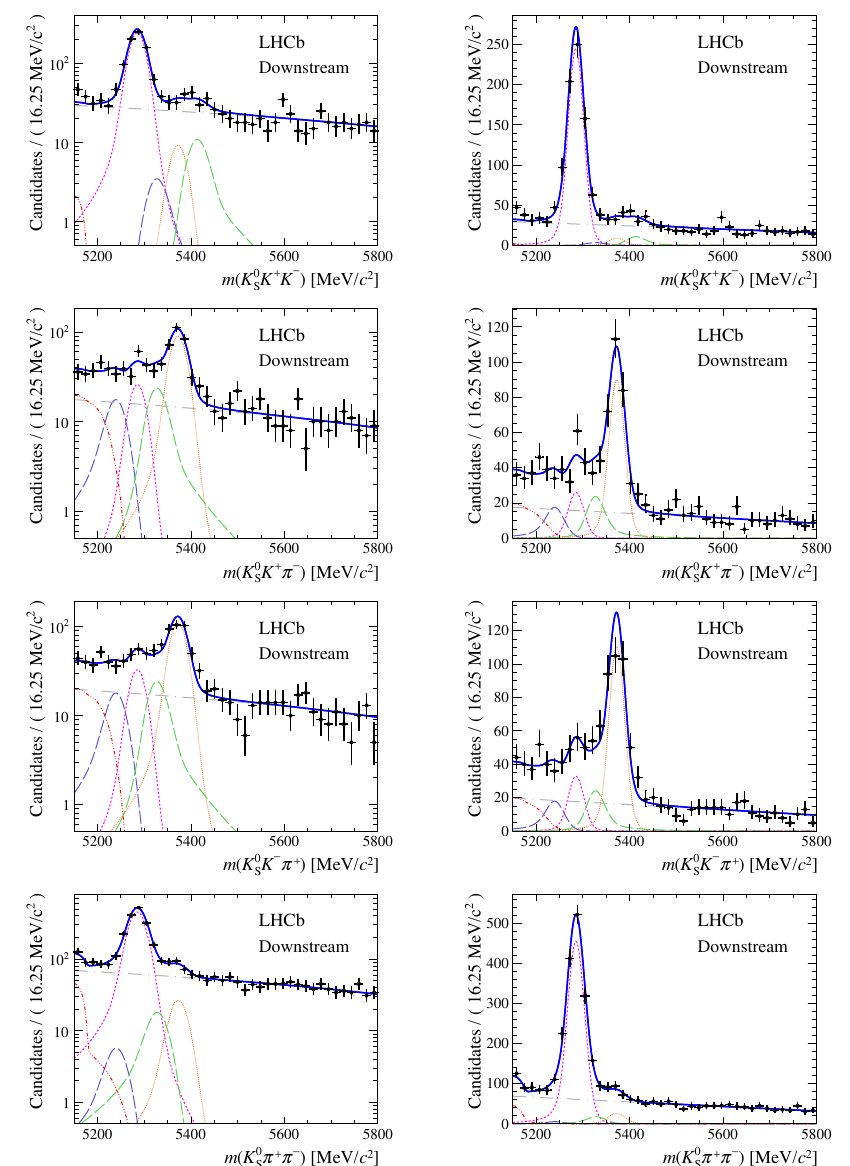
Figure 5 . Results of the simultaneous (cid:12)t to data (downstream, 2012b) with the BDT optimisation corresponding to the favoured decay modes. The modes K 0 K 0 (cid:25) + (cid:25) (cid:0) are shown from top to bottom. The left-hand side plots show the results with a logarithmic S scale and the right-hand side with a linear scale. Legend is similar to that of plots shown in (cid:12)gure 1.